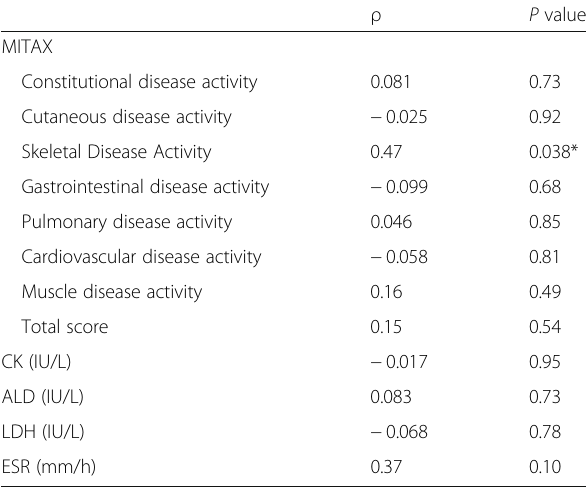
Table 4 Correlation of hsa-miR-4442 level in plasma and disease